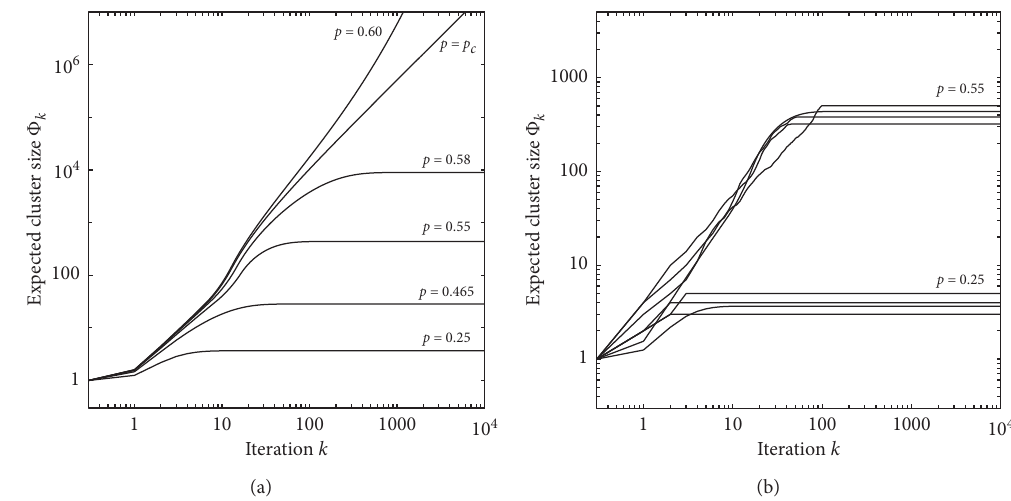
Figure 8: (a) The evolution of Φ p ’s. (b) The evolution of Φ k for single-site starting set with different k for single-site starting set with p � 0 . 25 and p � 0 . 55. The thick lines are calculated with the cluster growth model and the thin lines are individual simulation